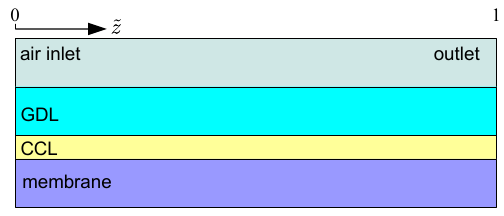
Figure 1. Sketch of the cathode side of a polymer electrolyte membrane fuel cell (PEMFC) with the straight oxygen channel. CCL, cathode catalyst layer, GDL, gas diffusion